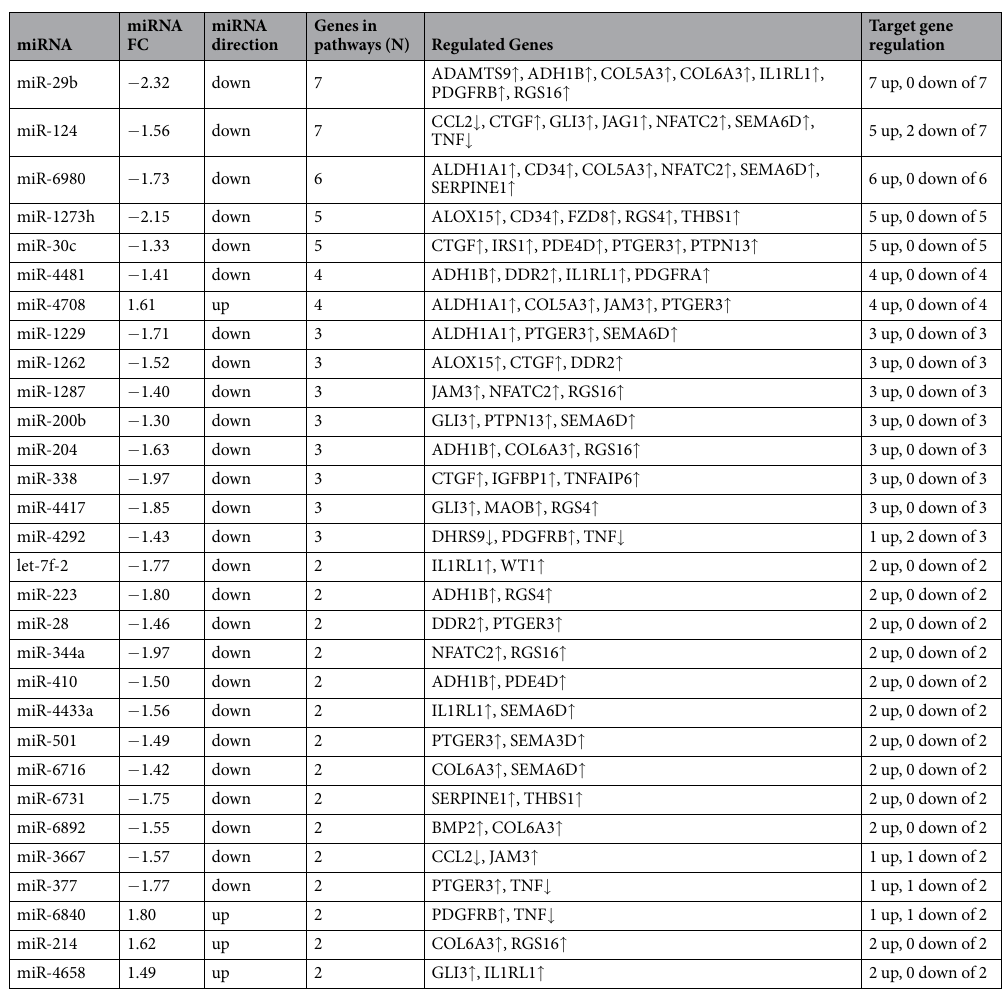
Table 4. Micro-RNAs (miRNAs) influencing more than one gene within pathways enriched in cells from AlaGln-supplemented PDF Analysis of PD effluent cells of the 4 h PET time point. Comparison control without AlaGln versus 8 mM AlaGln in PDF. ↑ up/ ↓ down regulated